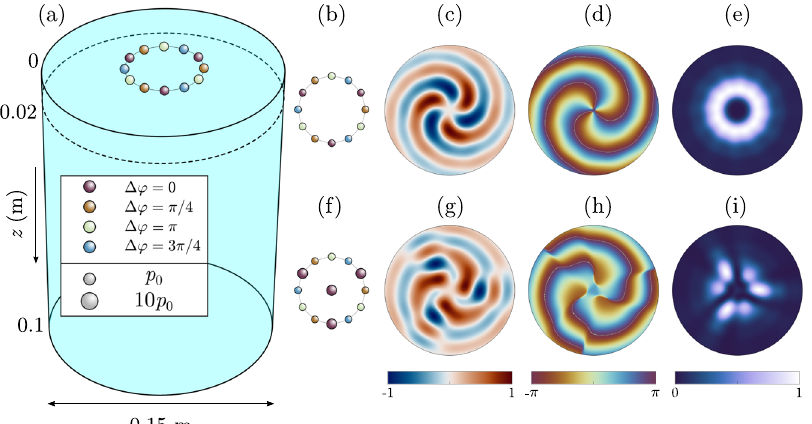
Fig. 4 Analogy to Discrete Phased Acoustic Sources. a FEM geometry showing ring of 12-point acoustic sources (coloured spheres), with relative phase and amplitude shown by their colour and size respectively, atop cylindrical region of water with cylindrical radiation conditions on all boundaries. b geometry of case (I) for conventional approximation of acoustic OAM beams; real pressure, phase, and acoustic intensity are shown in c , d , e respectively for this case at a depth of 20 mm below the source position. f geometry of case (II), where amplitude modulation is incorporated by an additional central source and by altering the amplitudes of three of the sources around the ring. g – i are analogous to c – e respectively for case (II), showing the amplitude modulation of the acoustic OAM beam.